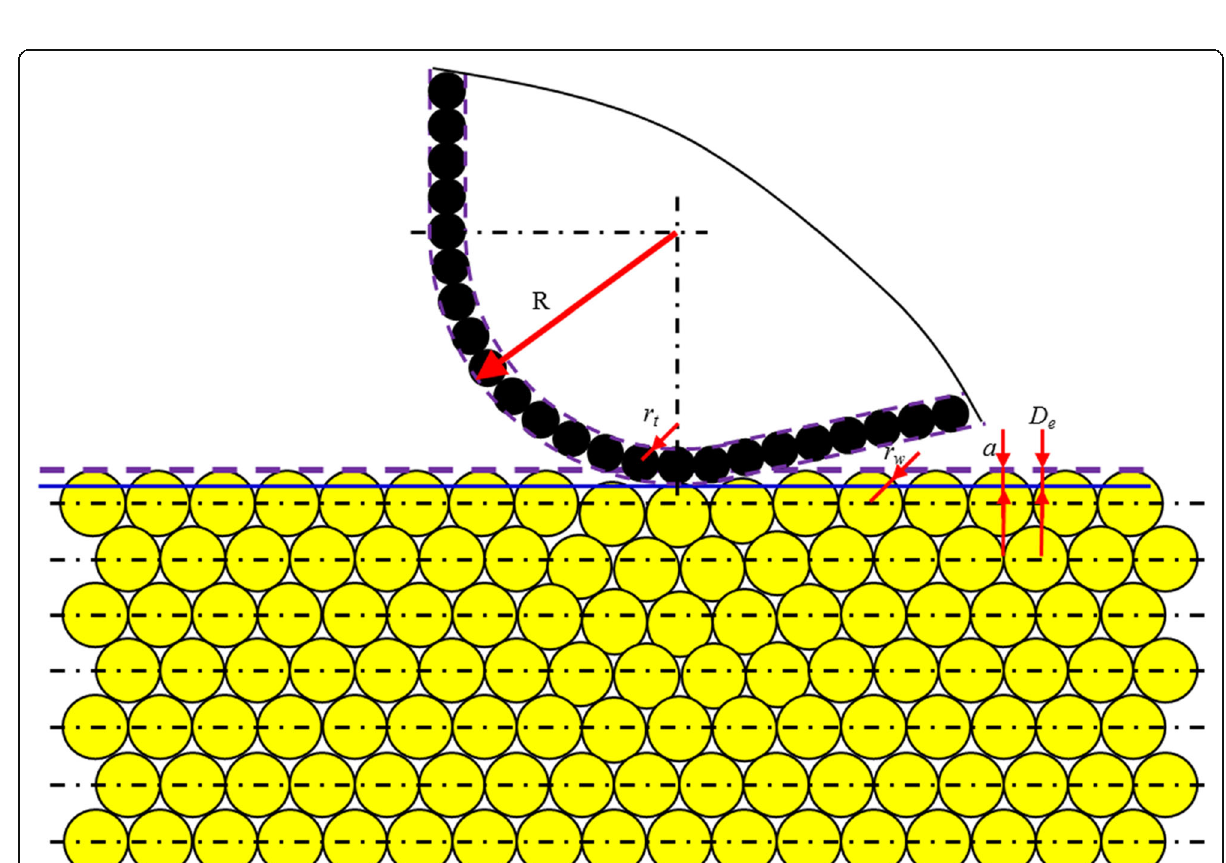
Fig. 15 Schematic illustration of cutting-based single atomic layer removal at the ratio of a/r w smaller than